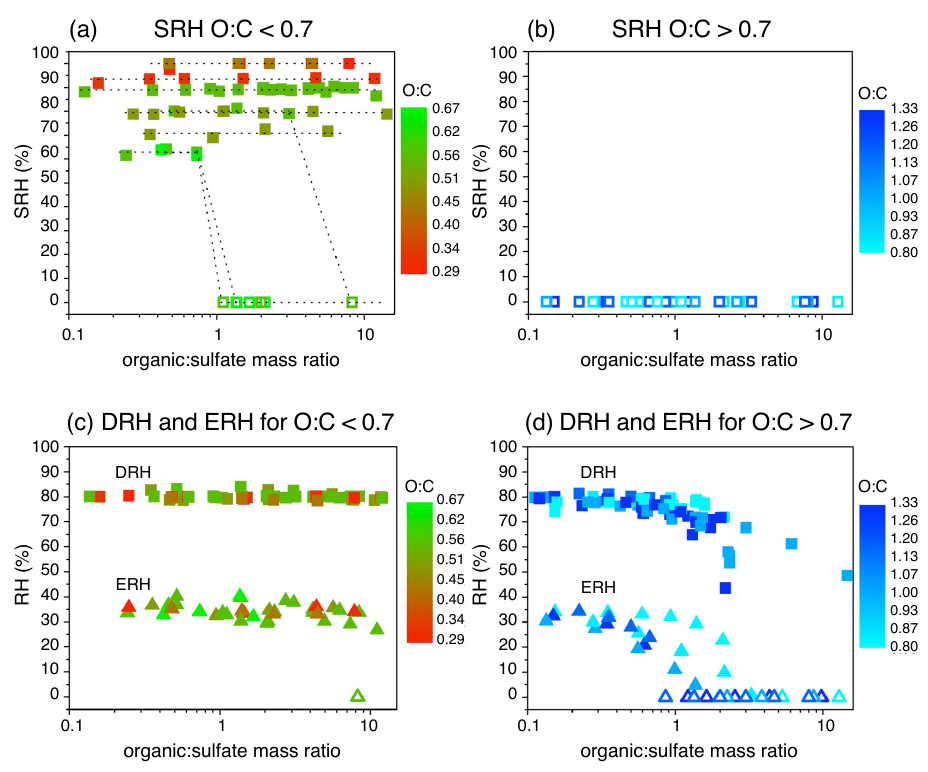
Fig. 2. Measurements of separation relative humidity (SRH), efflorescence relative humidity (ERH), and deliquescence relative humidity (DRH). Axes denote the observed relative humidity (RH) of a transition and the organic-to-sulfate mass ratio of a studied mixed system. Data are segregated between the left and right sets of panels for low ( < 0.7) and high ( > 0.7) oxygen-to-carbon (O:C) elemental ratios of the organic material. Open symbols indicate that no phase transition was observed. In some cases SRH was not probed below 35–40% RH because ammonium sulfate or the organic material crystallised. Phase transitions for temperatures ranging from 290 to